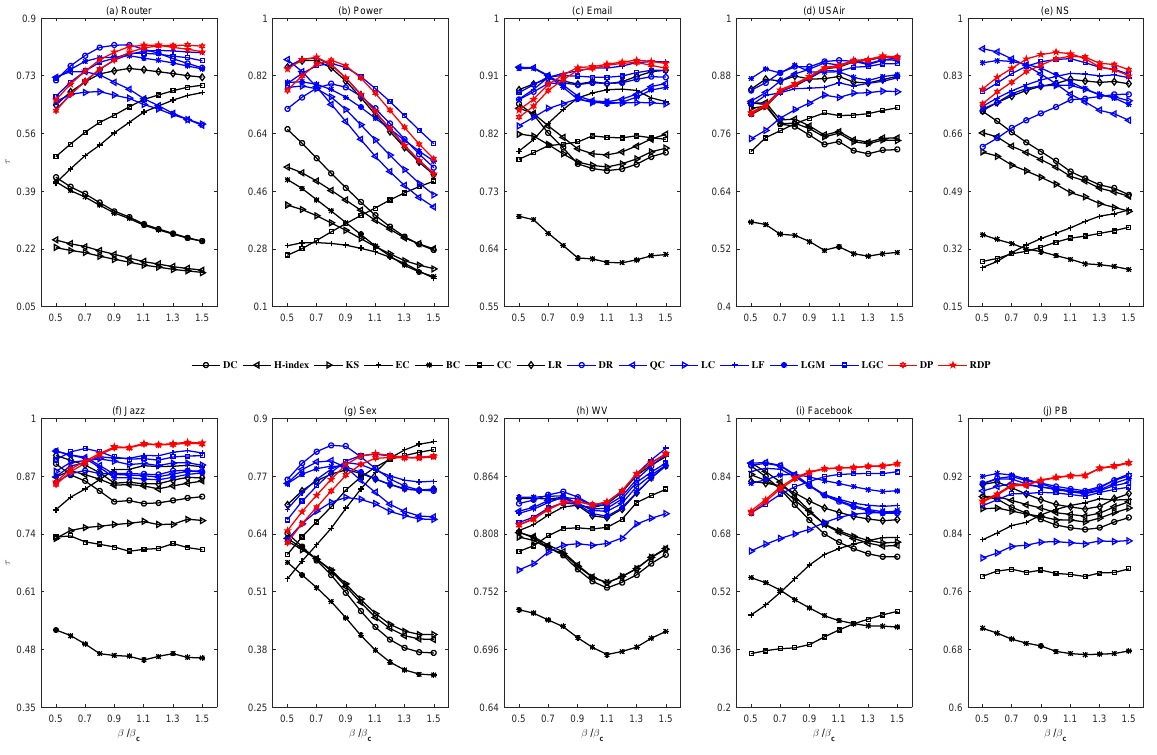
Figure 3. The algorithms’ accuracies measured by Kendall’s Tau for different β .